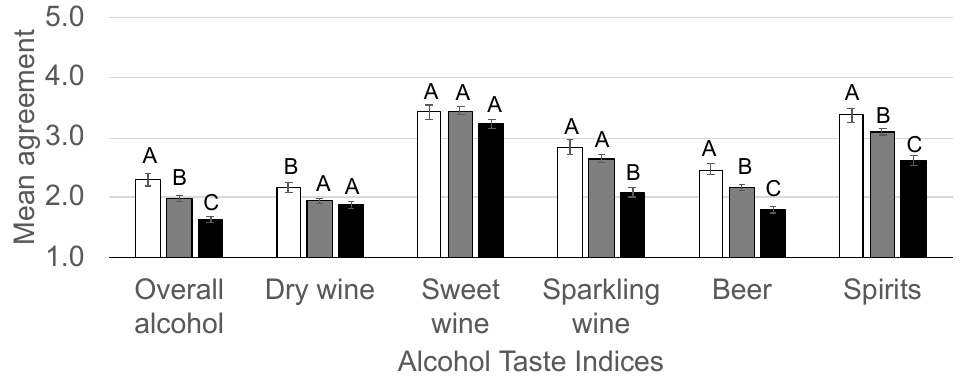
Figure 4. Mean scores for the alcohol taste indices grouped by alcohol adventurousness (137 none, 478 low, 464 high). Significantly different means from three-way ANOVAs indicated with different letters.